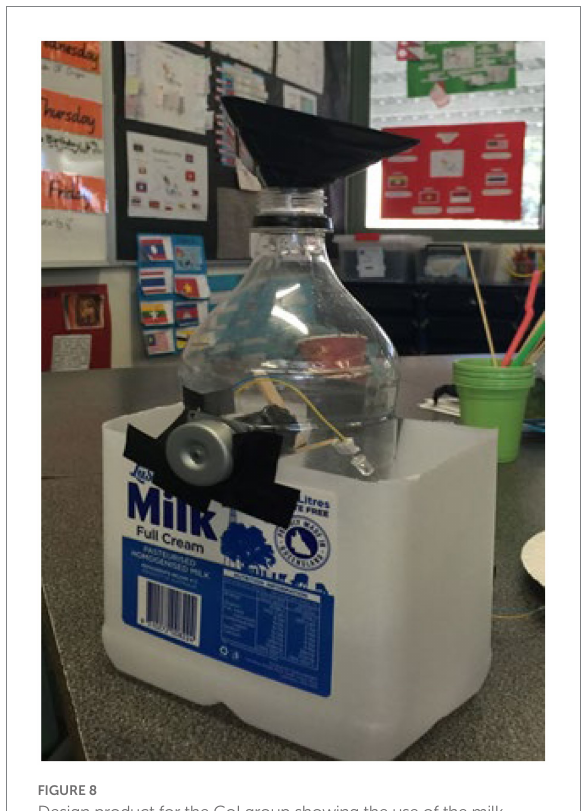
FIGURE 8 Design product for the CoI group showing the use of the milk bottle.